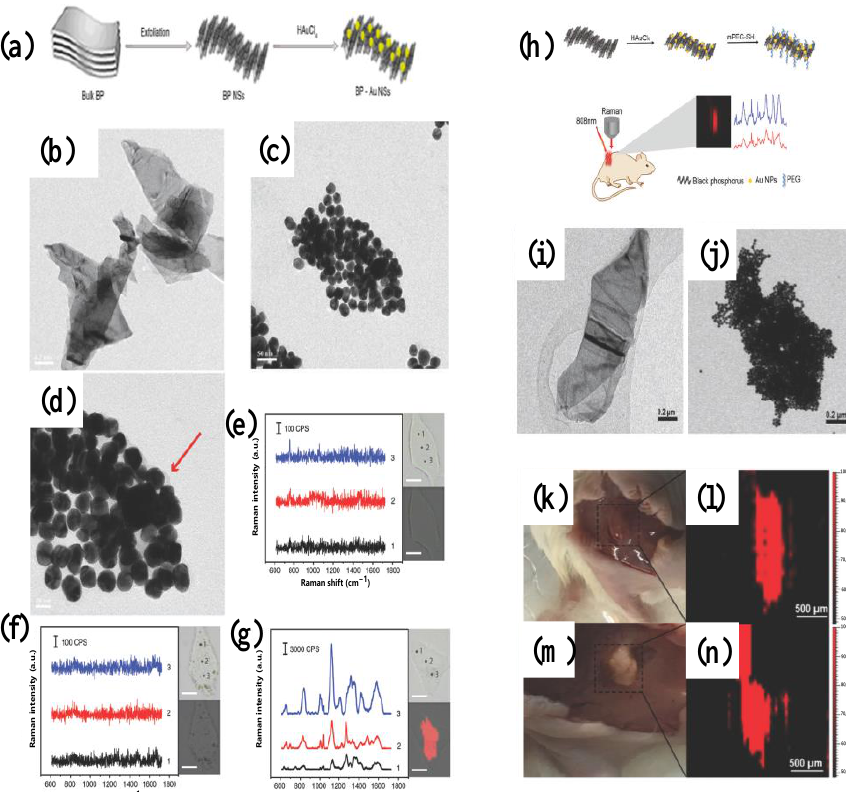
Figure 7. ( a ) Schematic illustration of synthetic process of BP-Au nanosheets. ( b ) TEM image of BP nanosheets. ( c , d ) Overall and enlarged TEM images of BP-Au NPs nanosheets. ( e ) Raman mapping and corresponding spectra of HepG2 cells incubated with ( e ) fresh medium. ( f ) BP nanosheets and ( g ) BP-Au NPs. Reprinted from Ref. [98] with permission of 2018 Walter De Gruyter. ( h ) Schematic illustration of the fabrication of BP–Au nanosheets and biomedical applications. ( i , j ) TEM image of BP sheets and BP–Au NPs nanosheets. ( k , m ) Photographs of tumor tissue injected with BP–Au NSs before and after NIR laser irradiation. ( l , n ) SERS images of tumor tissue injected with BP–Au NSs before and after NIR laser irradiation. Reprinted from Ref. [99] with permission of 2017 Royal Society of Chemistry.